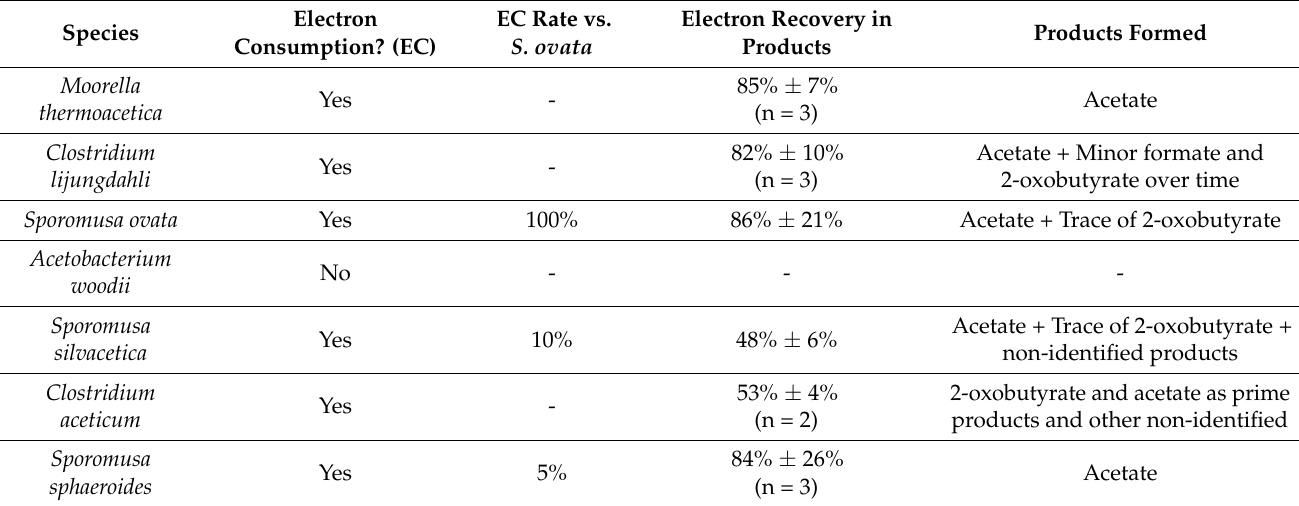
Table 3. Microorganisms were tested by Nevin and his team [96] to check the solid-state electrode’s ability to receive electrons and to use CO 2 as the terminal electron acceptor, following the Wood-Ljungdahl pathway. Electron EC Rate vs. Electron Recovery in Species Products S. ovata Consumption? (EC) Products